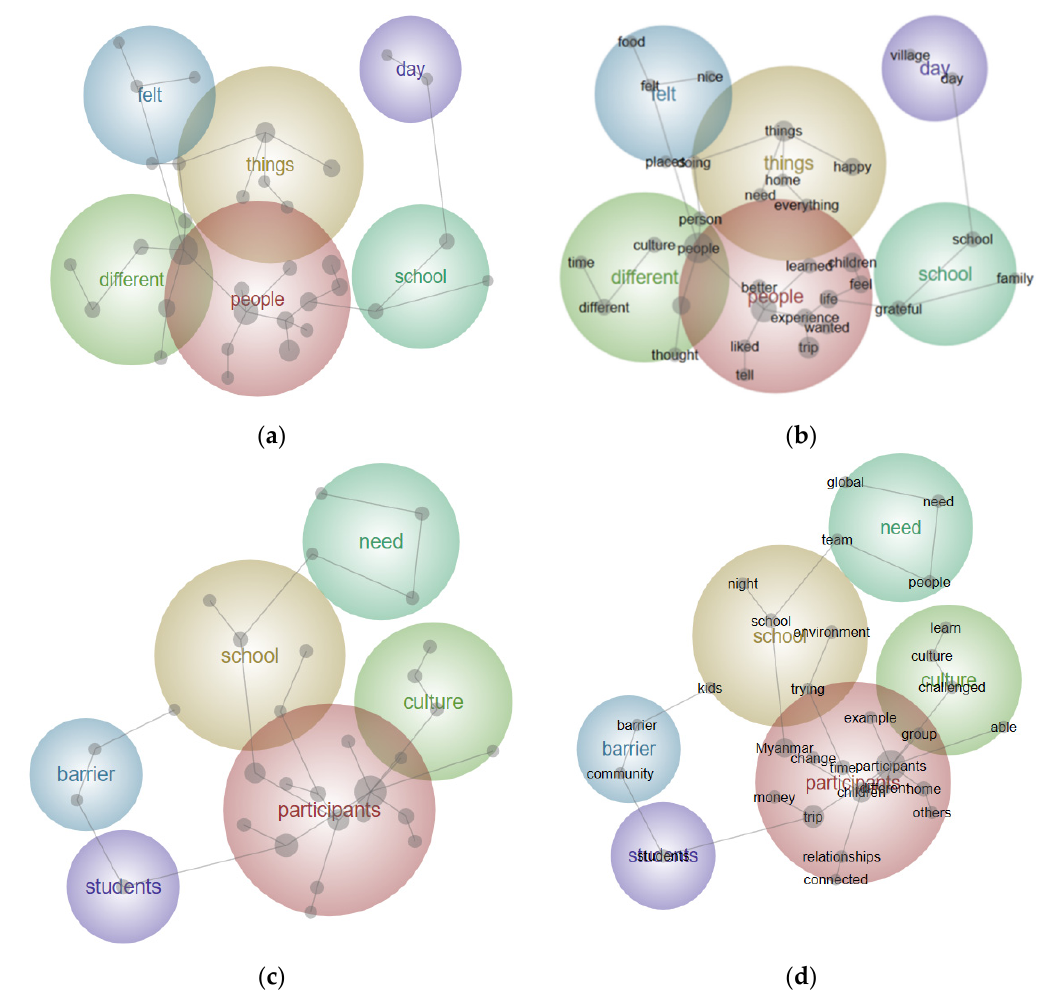
Figure 3. ( a ) Basic concept map participant interviews; ( b ) detailed concept map participant interviews; ( c ) basic concept map leader interviews; ( d ) detailed concept map leader interviews.